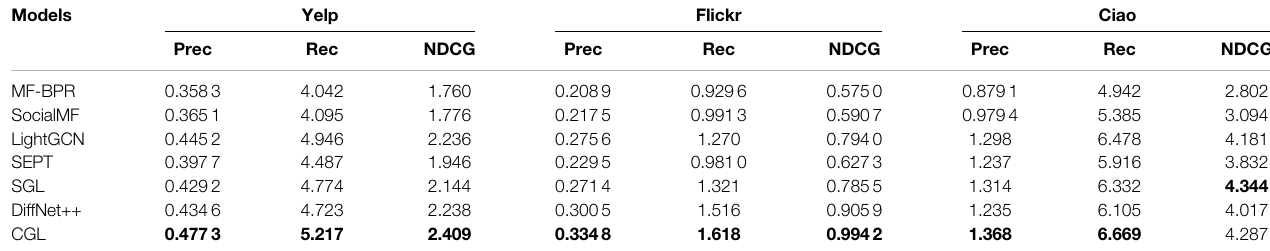
TABLE 4 | Overall comparison ( K = 20). The best results are in bold.